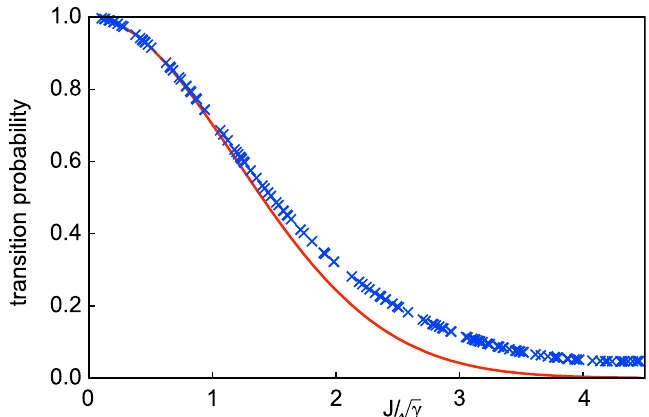
Figure 2: The BE formula in Eq. (47) (red solid line) and the zeroth-order approxi- mation ( × , blue) in Eq. (46) for ˆ H in Eq. (48). We set N = 10. 2 − body